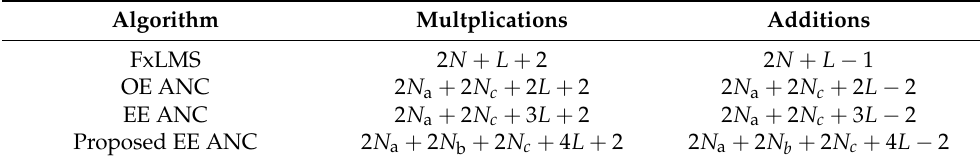
Table 1. Computational